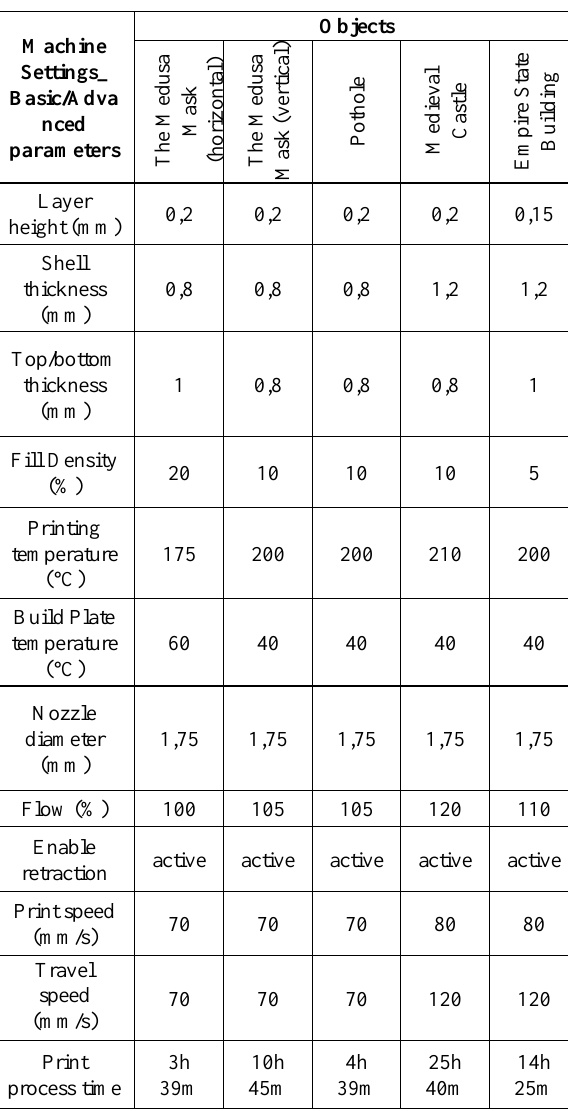
Table 19. Machine settings, Basic/Advanced